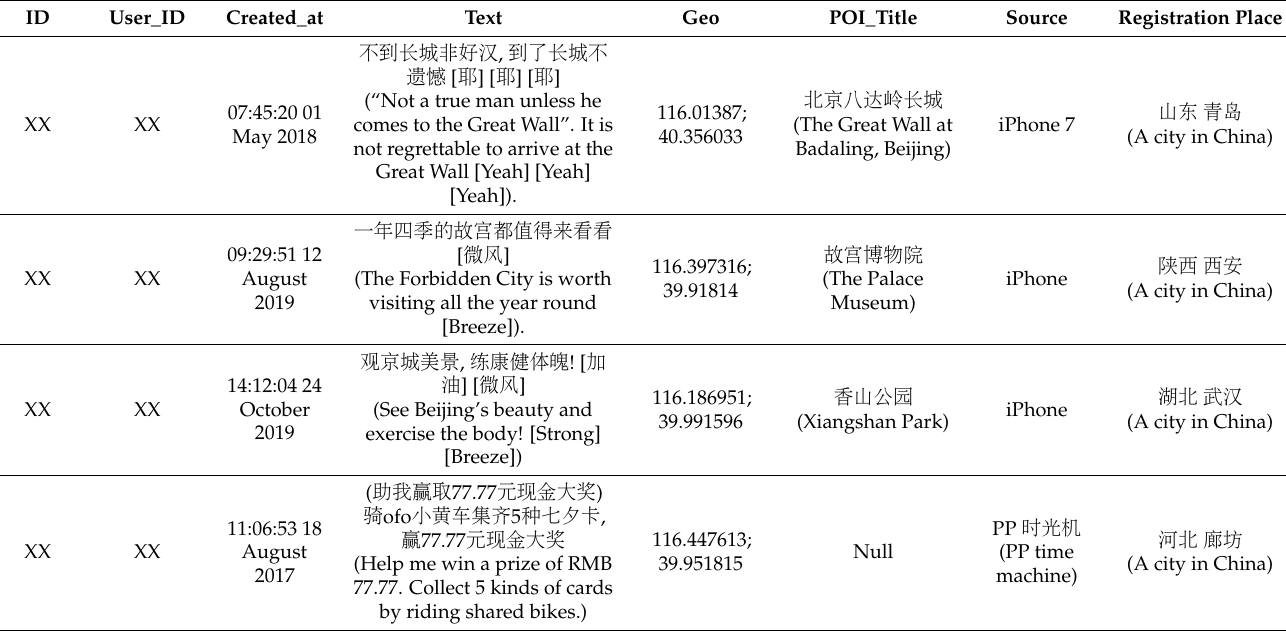
Figure 1. The distribution of the selected attractions in Beijing. Table 1. Samples of geotagged Sina Weibo